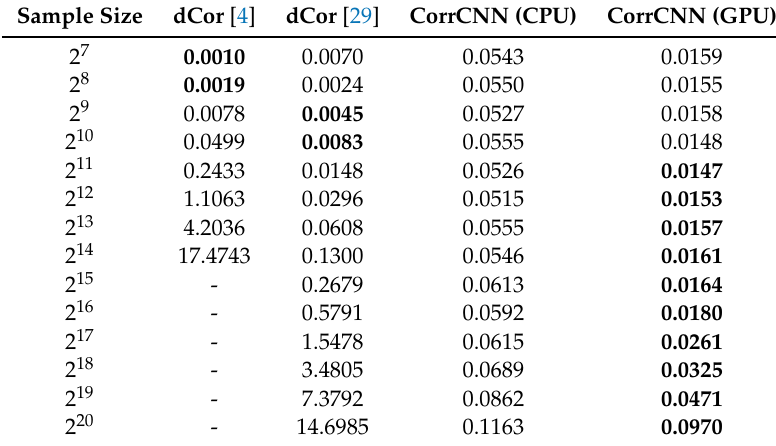
Table 3. Comparison of running times for distance